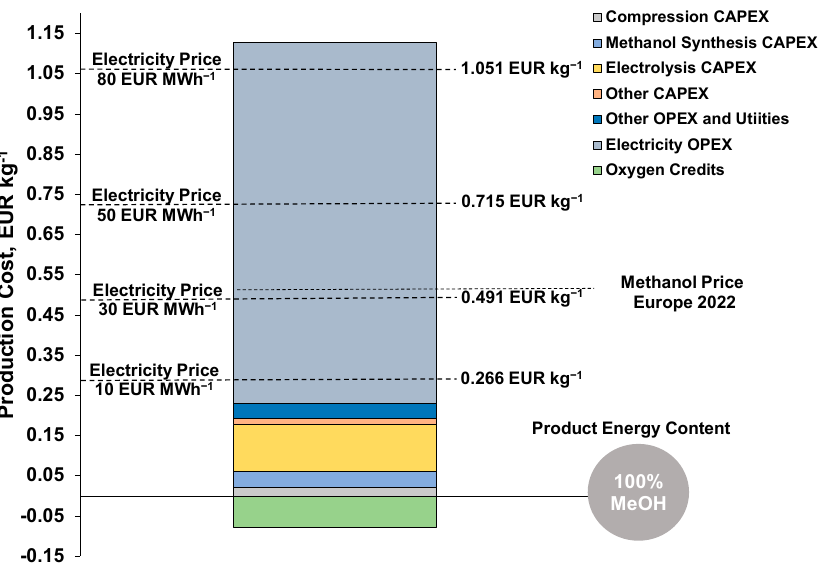
Figure 14. Methanol production costs breakdown and effect of electricity price in the MeOH case. In Figure 15, sensitivity analysis is conducted to show the influence of several cost components on the total production cost. An improvement in the electrolyzer system efficiency to 40 kWh/kg could decrease the costs by 24.9%, whereas a system efficiency of 70 kWh/kg could increase the costs by 25.5%. In addition, assuming that electrolysis CAPEX is varied by ± 50%, a ± 9.6% cost decrease/increase can be expected. A 50% decrease/increase in the methanol synthesis and compressor costs could increase/decrease the methanol production cost by 3.0% and 1.8%, respectively. The rest of the CAPEX and the cost of utilities influence the price to a lower percent (<0.1% and 0.4%, respectively), where the rest of the OPEX (labor, insurance and taxes, overhead labor costs, and maintenance) could adjust the price by ± 2.4%. Finally, the oxygen selling price could reduce the price by 10.8% if the oxygen market price increases to EUR 100 t − 1 , if the price increases by 6.5%, and if the oxygen market price decreases to EUR 20 t − 1 .